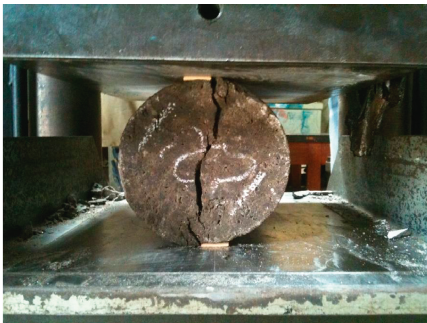
Figure 5: Performing splitting tensile strength test at the MRTC of the EiABC, Addis Ababa